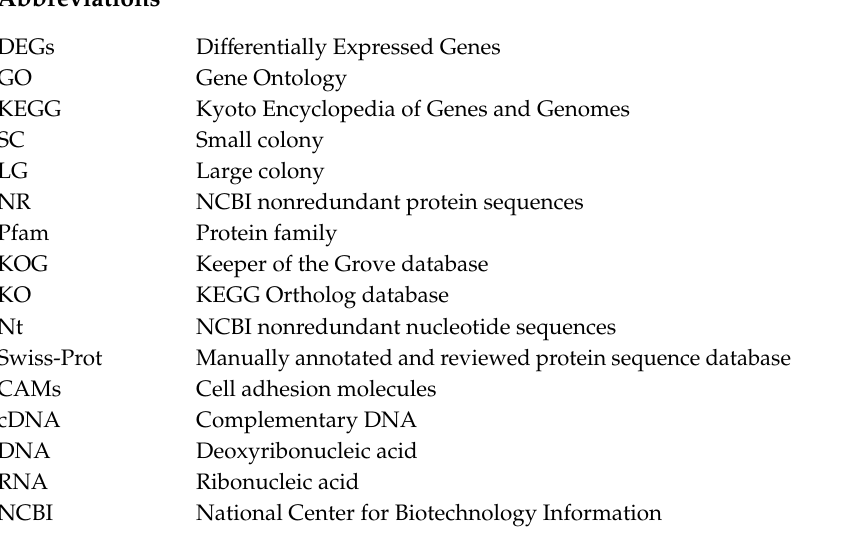
Figure S1: Unigene length distribution of transcriptome assembly in Romalea microptera, Table S1: Down Regulated Genes; Table S2: Up Regulated